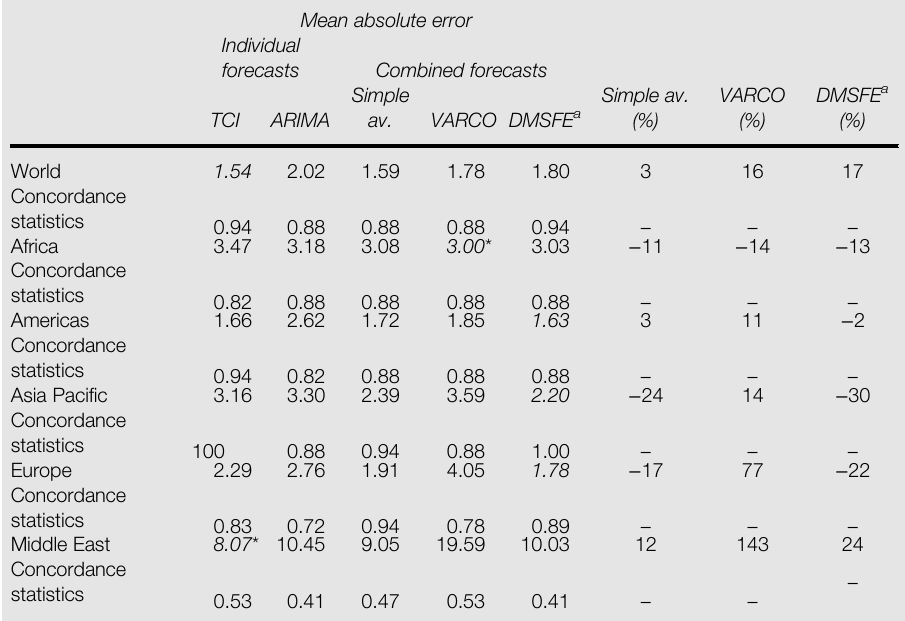
Table III Mean absolute error, concordance statistics and accuracy tests – overall